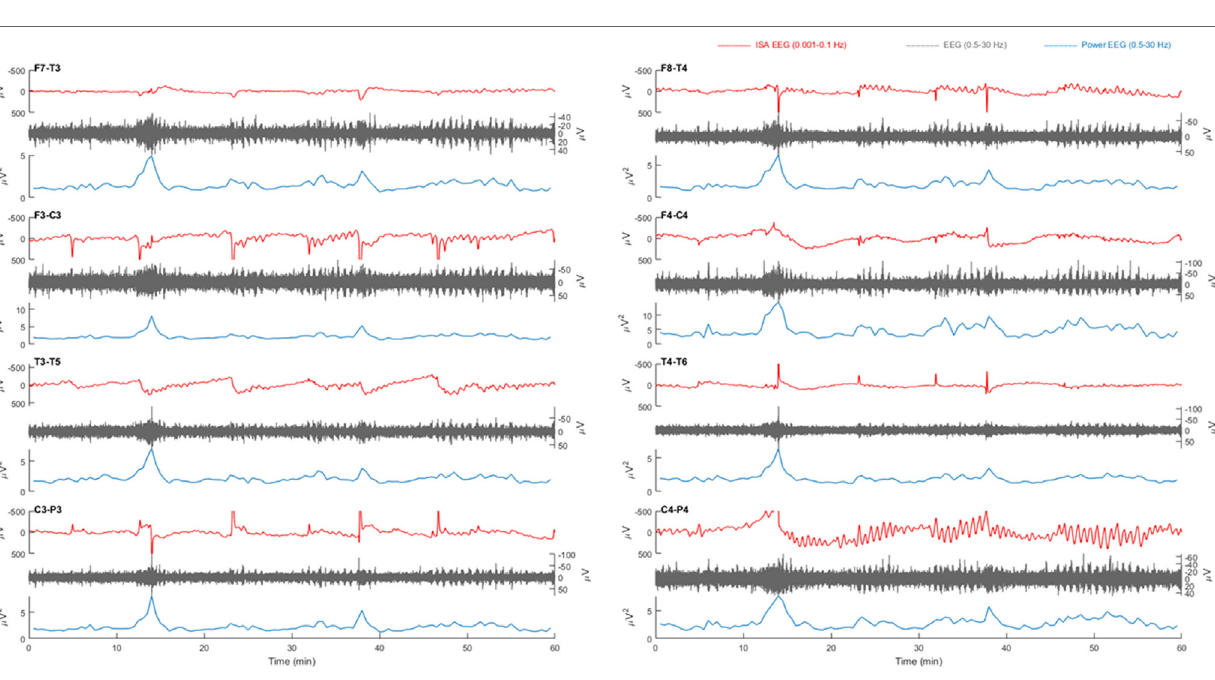
FigUre 5 | Example of a 1 h electroencephalography (EEG) overview from patient 1 with right-sided middle cerebral artery infarction. Electrode pairs F7-T3, F3-C3, T3-T5, and C3-P3 over the left hemisphere and F8-T4, F4-C4, T4-T6, and C4-P4 over the right hemisphere are displayed. Oscillatory infraslow activity (ISA, 0.001–0.1 Hz, red) is present over electrode pair C4-P4. The ISA is accompanied by simultaneous fluctuations of faster activity (0.5–30 Hz, gray), which is visible in the power of this frequency band